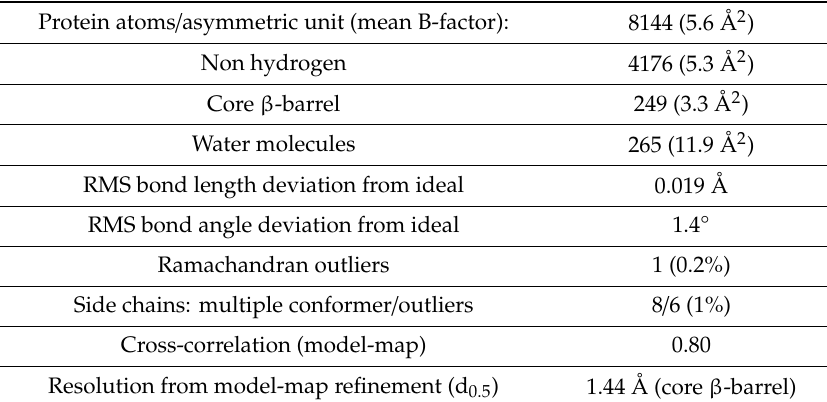
Table 2. Refinement of the atomic model.